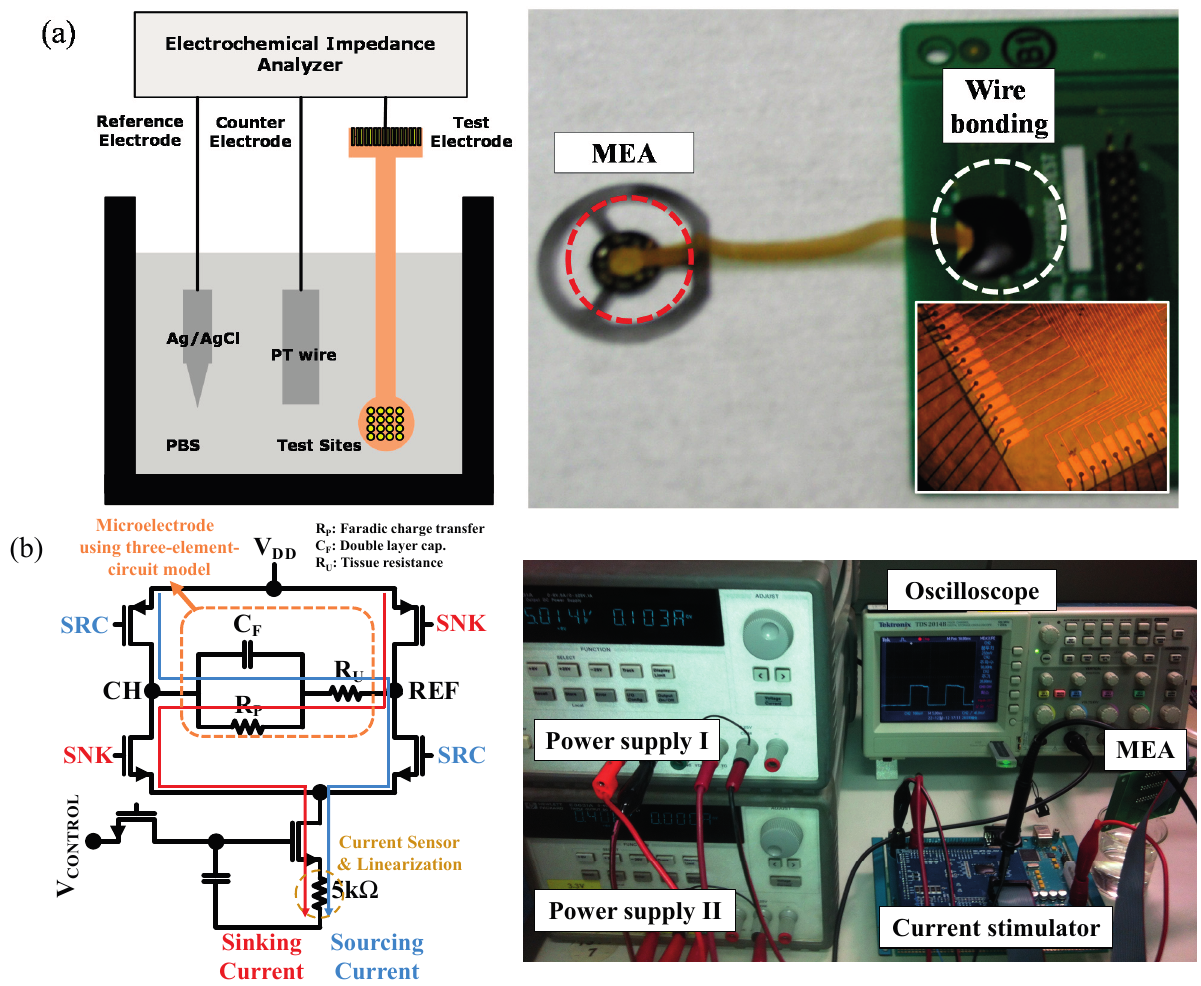
Figure 2. Experimental setup. ( a ) Interface impedance measurement (schematic of impedance measurement (left), fabricated MEA on PCB (right)); ( b ) Charge injection limit measurement (schematic of current stimulator (left), experimental setup